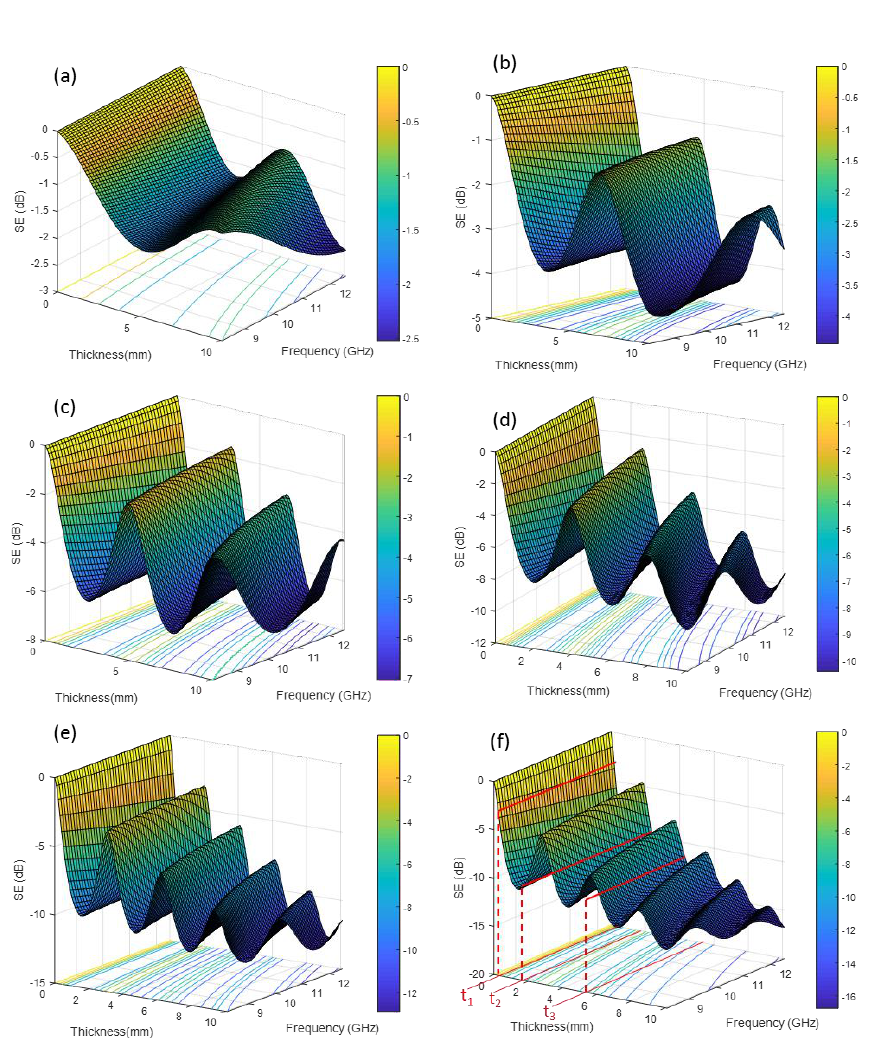
Figure 8. Shielding effectiveness of PBAT/GNP nanocomposites as a function of thickness and frequency for ( a ) 0, ( b ) 3, ( c ) 6, ( d ) 9, ( e ) 12, and ( f ) 15 wt % GNP content.